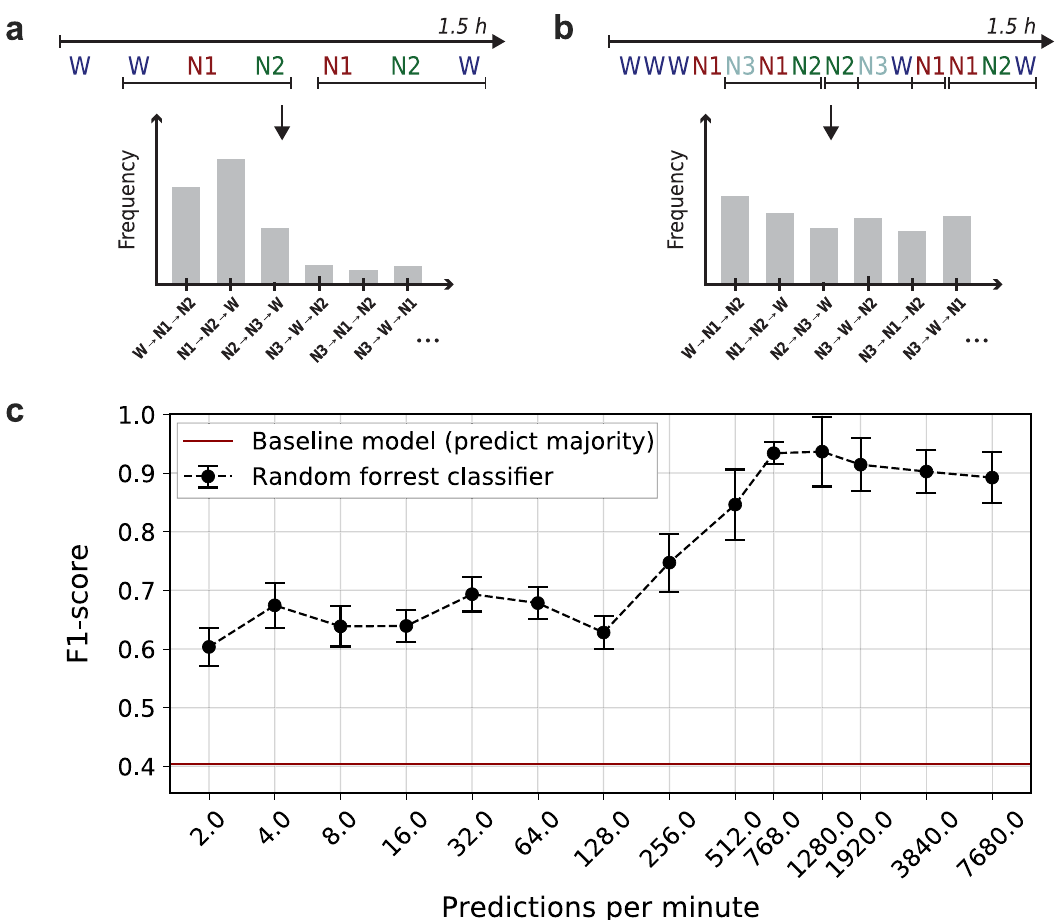
Fig. 4 Classi fi cation performance on the task of separating healthy control subjects and OSA patients in a population of N = 80 (25 controls, 55 OSA patients) using a Random Forrest classi fi er on sleep stage transition triplet frequencies extracted using U-Sleep outputs of varying frequency. a and b Illustrate the process of extracting sleep stage triplet transition frequencies from low ( a ) and high ( b ) frequency outputs from U-Sleep, which are passed to the classi fi er. c Shows classi fi cation performance as a function of sleep staging frequency. Increasing the temporal resolution improved the predictive performance of the downstream classi fi er from its initial low mean F1 of 0.60 to nearly perfect classi fi cations with mean F1 scores in range 0.89 – 0.94 at frequencies ≥ 768 predictions/minute. The black curve shows the mean performance with standard deviation error bars computed over 50 repetitions of the experiment using randomly con fi gured classi fi ers. The solid red line is the F1 score obtained using a baseline model which predicts only the majority class (OSA patient) independent its